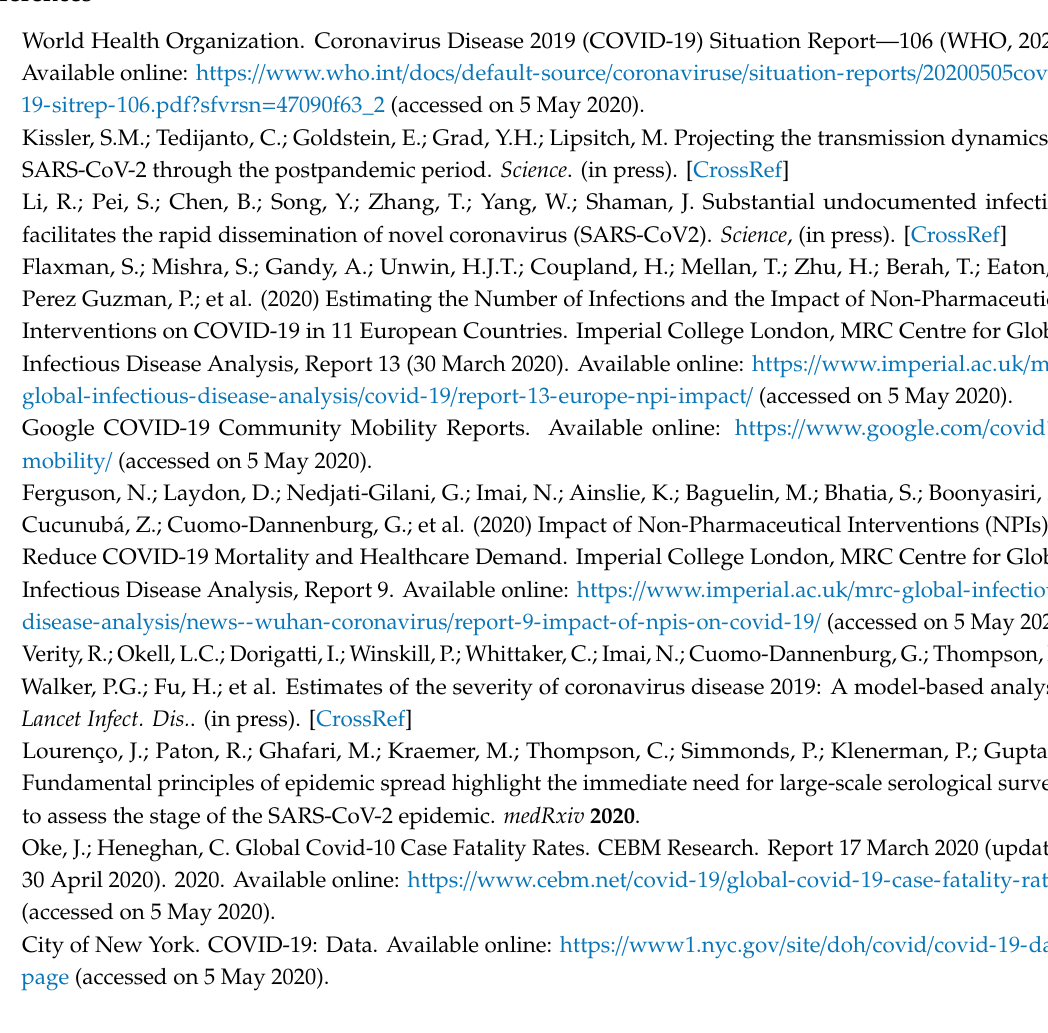
Table S1: Parameters (reproduction number and initial infections) obtained by using additional interventions in the modeling, Figure S1: Estimates of infections and deaths obtained by including additional interventions dates in the model, Figure S2: Forecast for daily deaths in Spain over the upcoming months in di ff erent scenarios, Figure S3: Forecast for daily deaths in La Rioja over the upcoming months in di ff erent scenarios, Figure S4: Forecast for daily deaths in La Rioja (excluding data from elderly retirement homes with reported cases) over the upcoming months in di ff erent scenarios, Figure S5: Forecast for daily deaths in Spain over the upcoming months in di ff erent scenarios, assuming full return to pre-pandemic period on 1 September 2020, Figure S6: Forecast for daily deaths in La Rioja over the upcoming months in di ff erent scenarios, assuming full return to pre-pandemic period on 1 September 2020, Figure S7: Forecast for daily deaths in La Rioja (after excluding data from elderly retirement homes with reported cases) over the upcoming months in di ff erent scenarios, assuming full return